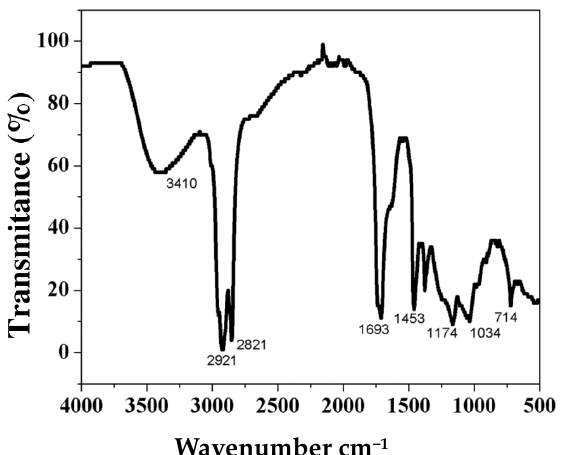
Figure 1. FTIR-ATR spectra of the type-phlorotannin polyphenol crude extract from S. filipendula.